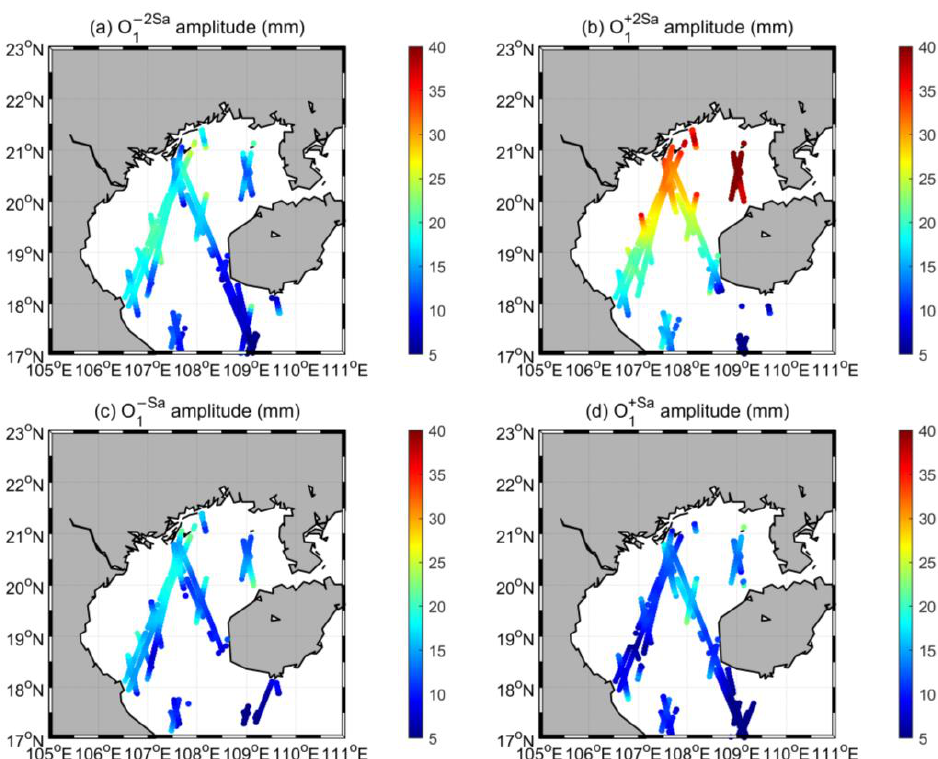
Figure 7. Estimated tidal amplitudes (unit: mm) in the Gulf of Tonkin from multi-satellite altimeter